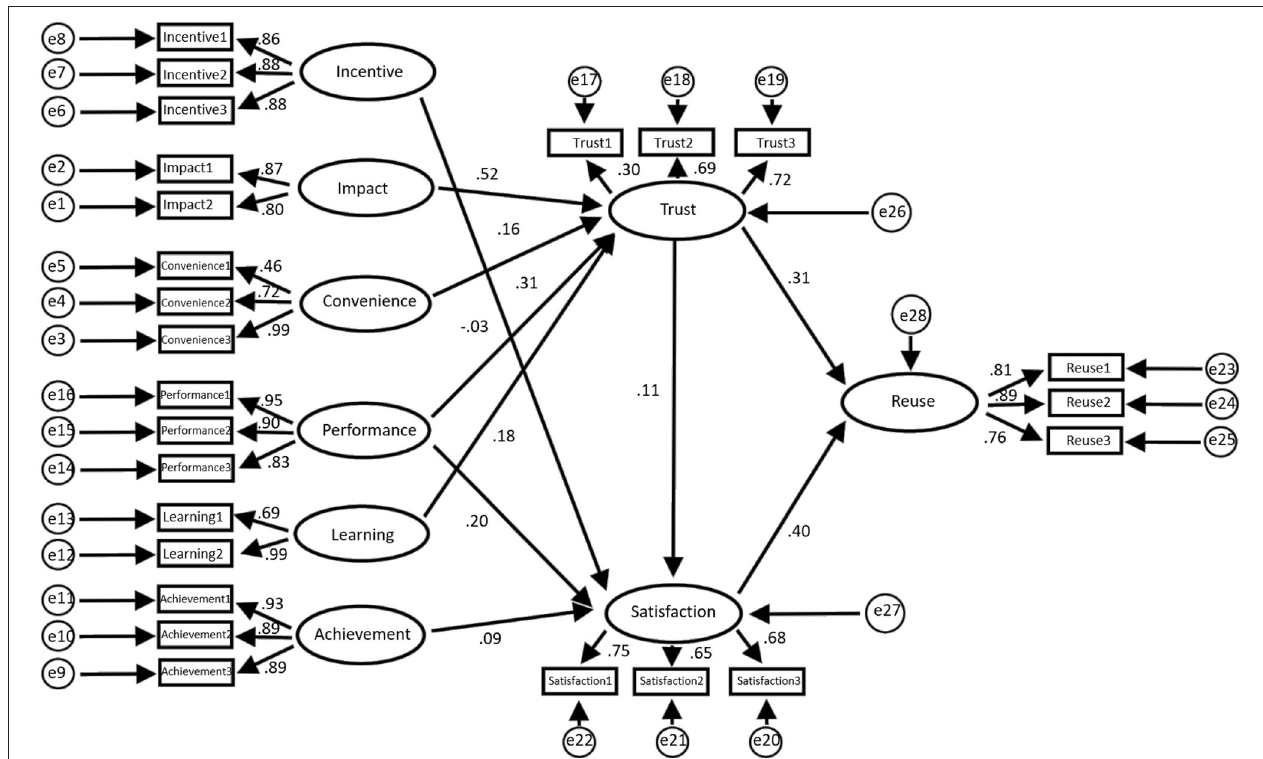
FIGURE 6 | Employee